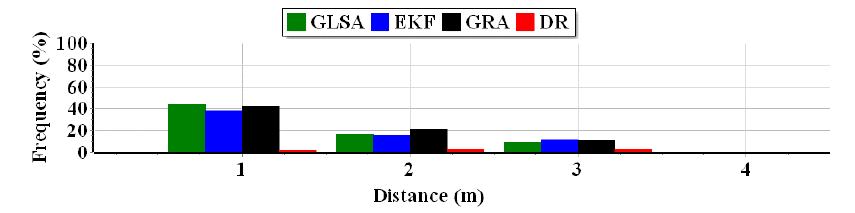
Figure 14. Percentage of distance to reference position from the estimated position during 100 SV